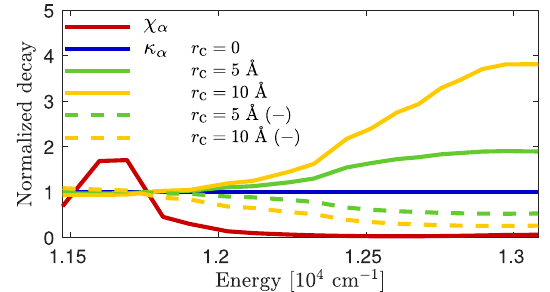
FIG. 4. Excitonic decay rates. Normalized decay rates from the excitonic manifold to the ground state for different processes in the B850 band of LH2: radiative (red) and nonradiative with increasing bath correlation length (blue, green, and yellow solid lines). The dashed lines correspond to models with the same correlation length but assuming anticorrelated bath fluctuations for pigment couples that have opposite transition dipole mo- ments. The decay rates are normalized such that, on average, they all give the same decay rate from a thermal exciton distribution. The results are obtained as ensemble averages over 10 4 realiza- tions of static